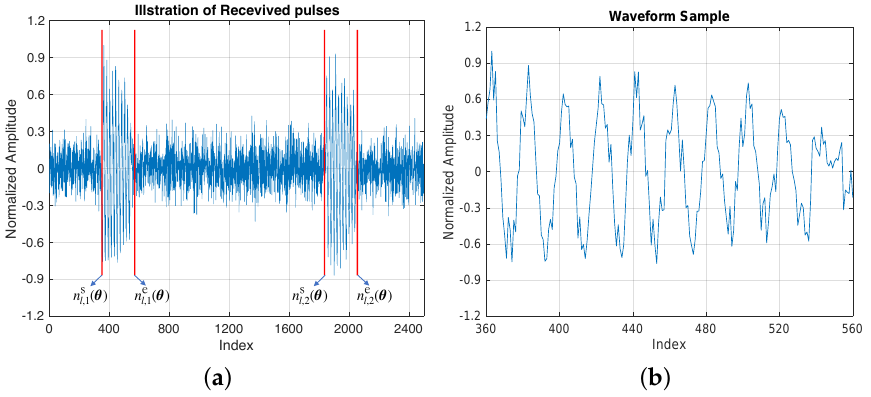
Figure 3. The extraction process of samples in a received pulse pair signal measurement at the correct hypothetical θ with T p = 20 µ s and T r = 150 µ s. ( a ) Received signal contaminated by noise with signal-to-noise ratio (SNR) 10 dB. ( b ) Extracted samples of the first pulse by (27) at the hypothetical θ